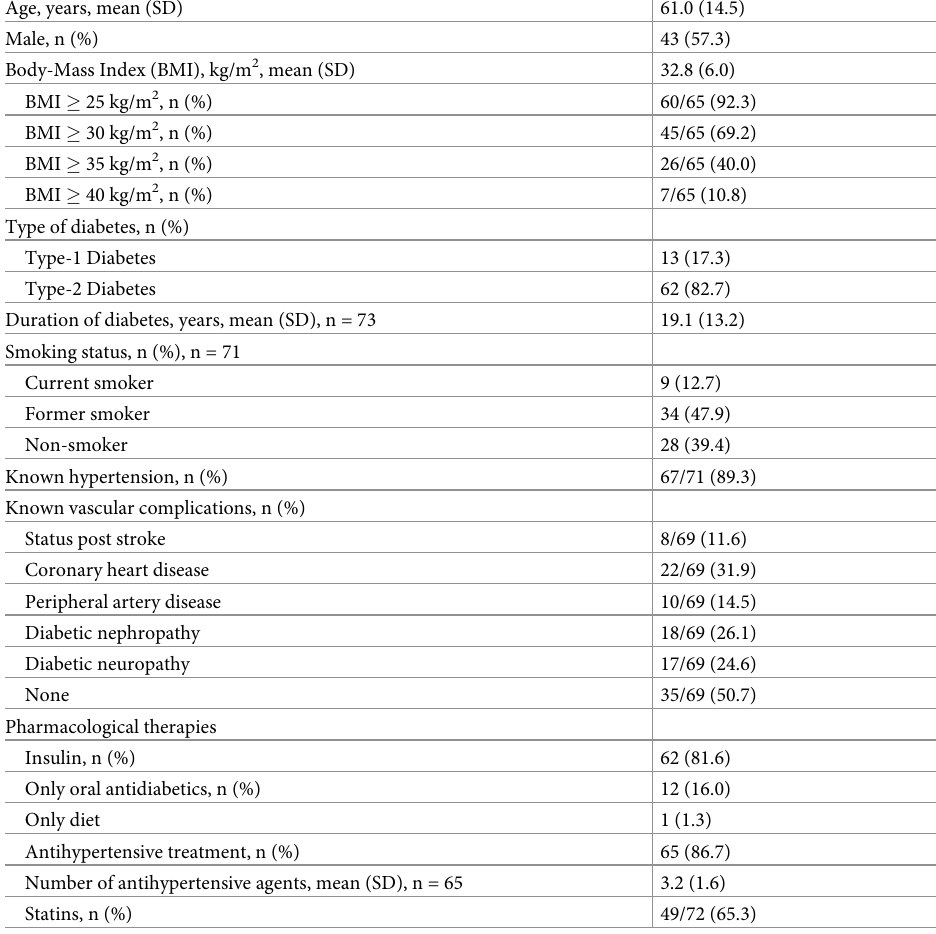
Table 1. Descriptive characteristics, n =